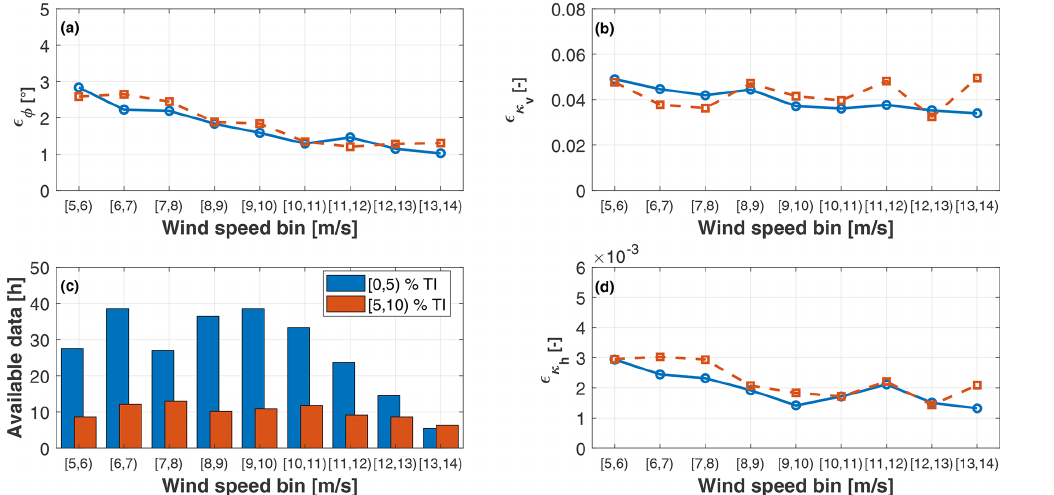
Figure 10. MAE (cid:15) vs. binned rotor-effective wind speed for binned TI. Yaw misalignment (a) ; vertical shear (b) ; hours of available data (c) ; horizontal shear (d) .